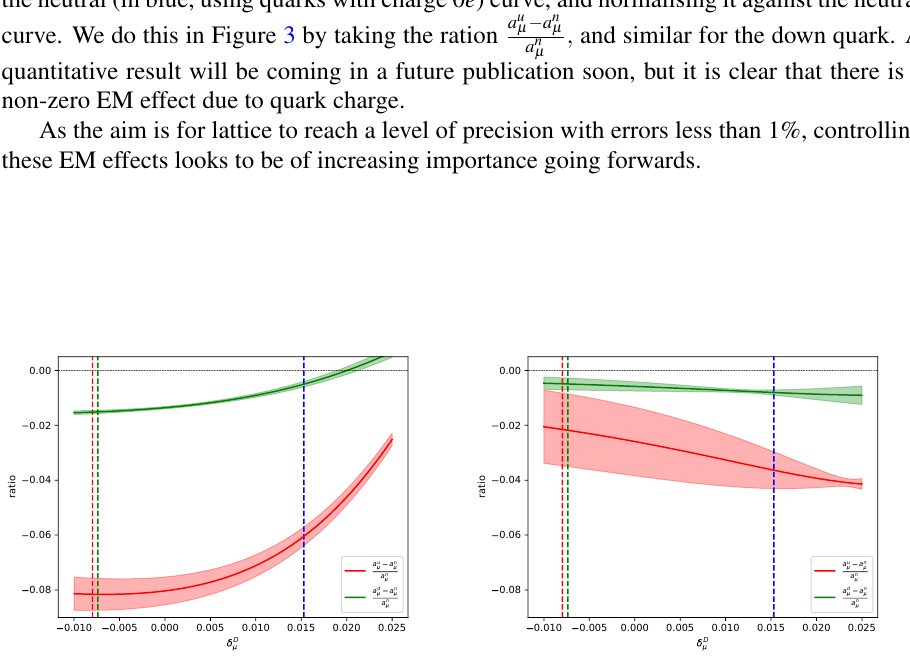
Figure 3: Deviation of charged contribution from neutral, normalised to the neutral contribu- tion, on each volume. left : 32 3 × 64, right : 48 3 ×